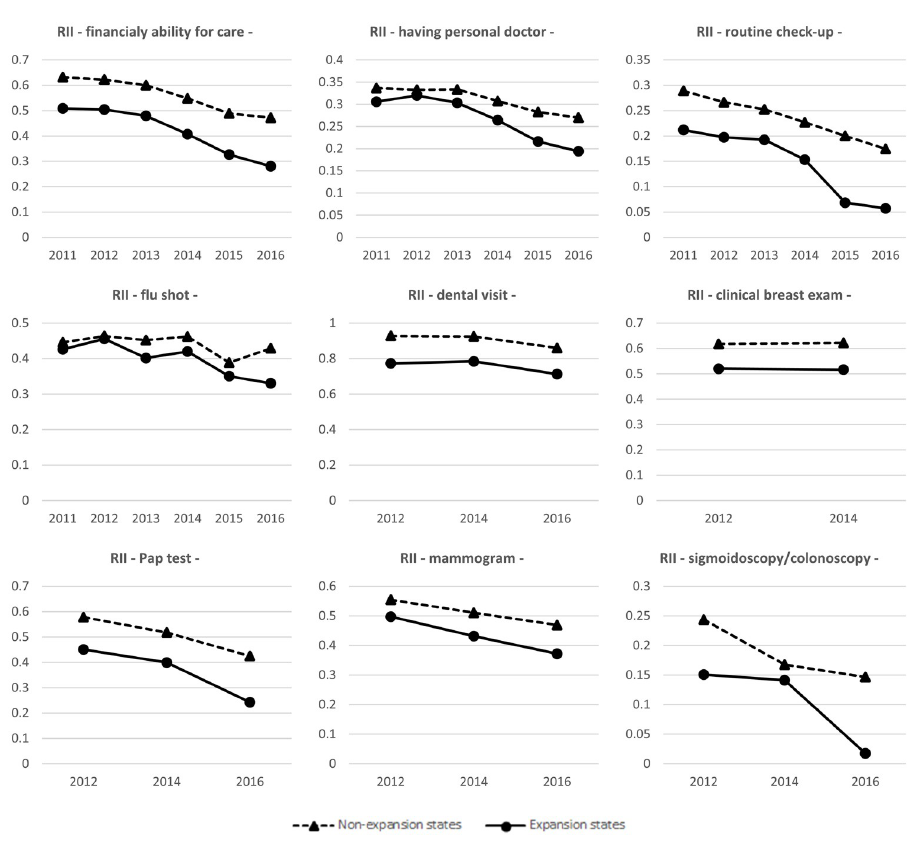
Fig 2. Trends in RII for expansion and non-expansion